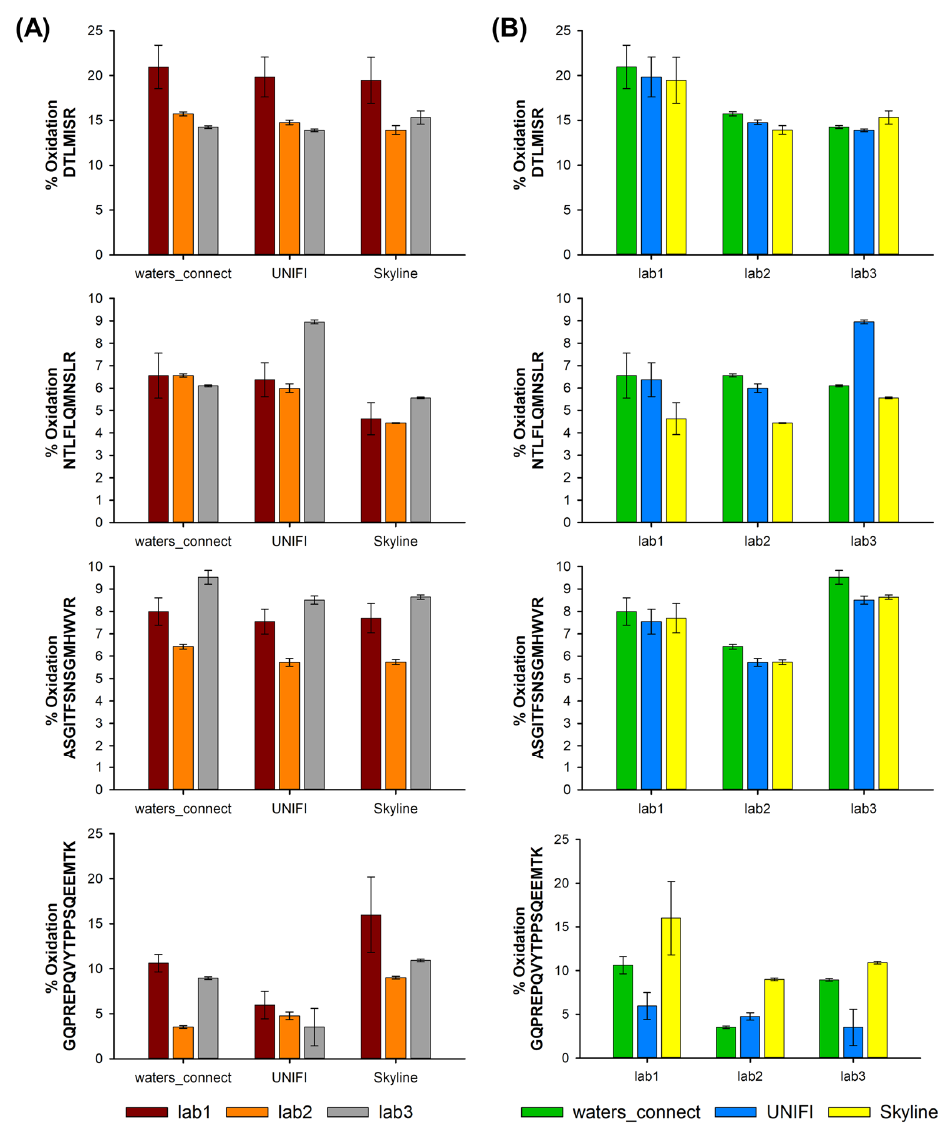
Figure 4. Percentage of oxidation observed on four different peptides, namely, DTLMISR, GQPREPQVYTLPPSQEEMTK, ASGITFSNSGMHWVR and NTLFLQMNSL, evaluated ( A ) by using three different software solutions (waters_connect, UNIFI and Skyline) on data obtained in ( B ) three different laboratories (lab1, lab2 and lab3).